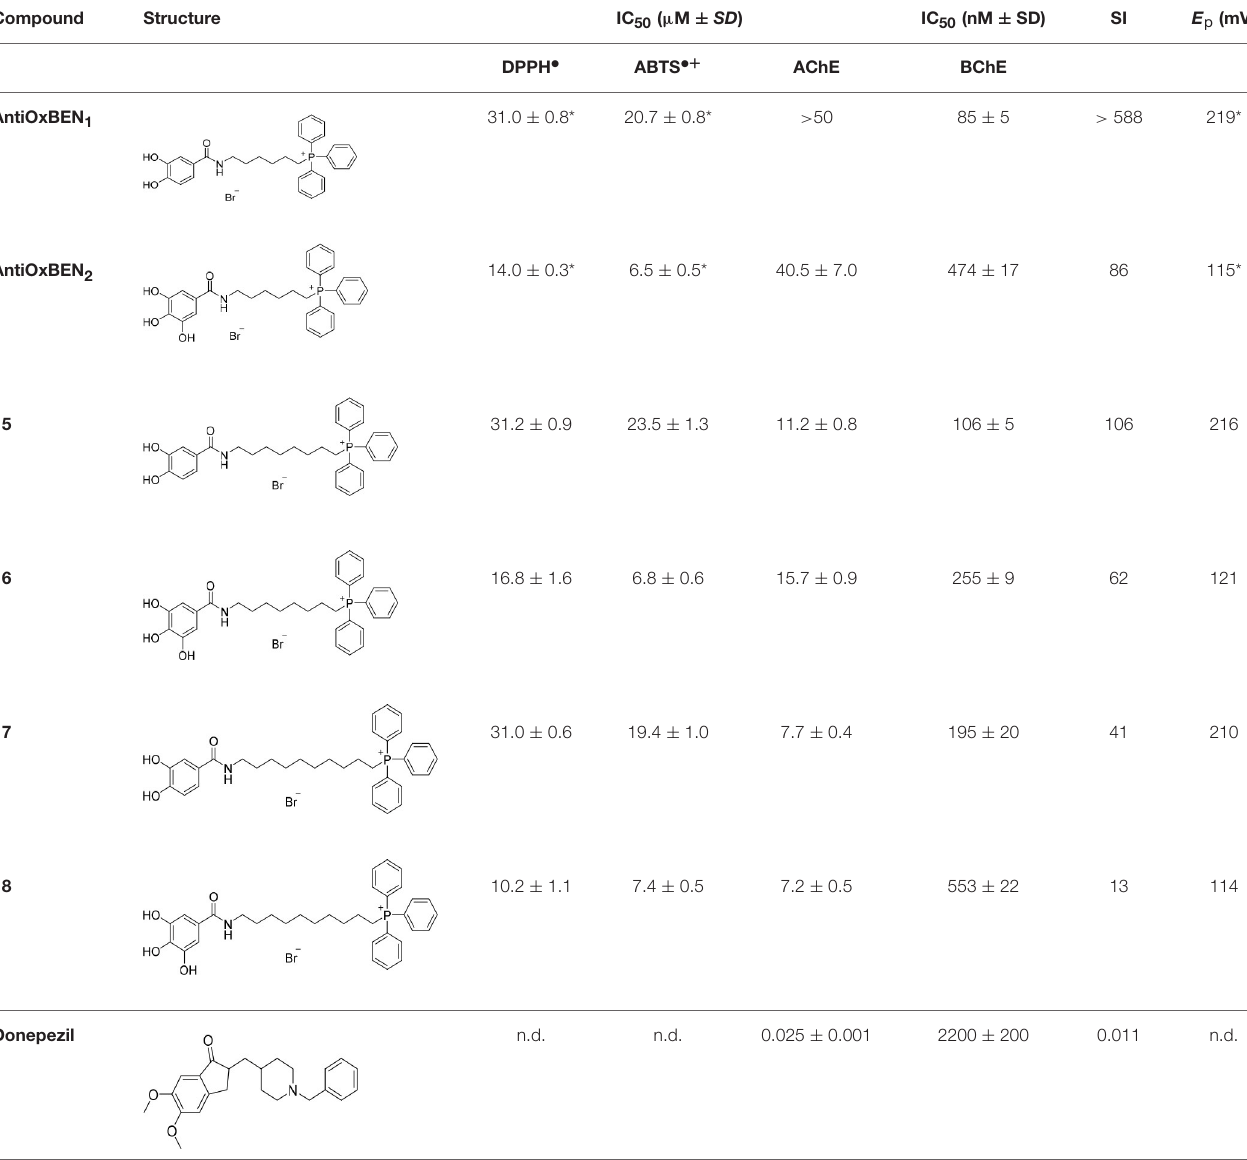
TABLE 1 | Total antioxidant capacity and ChEs inhibitory activity (IC 50 ) data of compounds AntiOxBEN 1 , AntiOxBEN 2 , 15–18 and donepezil.